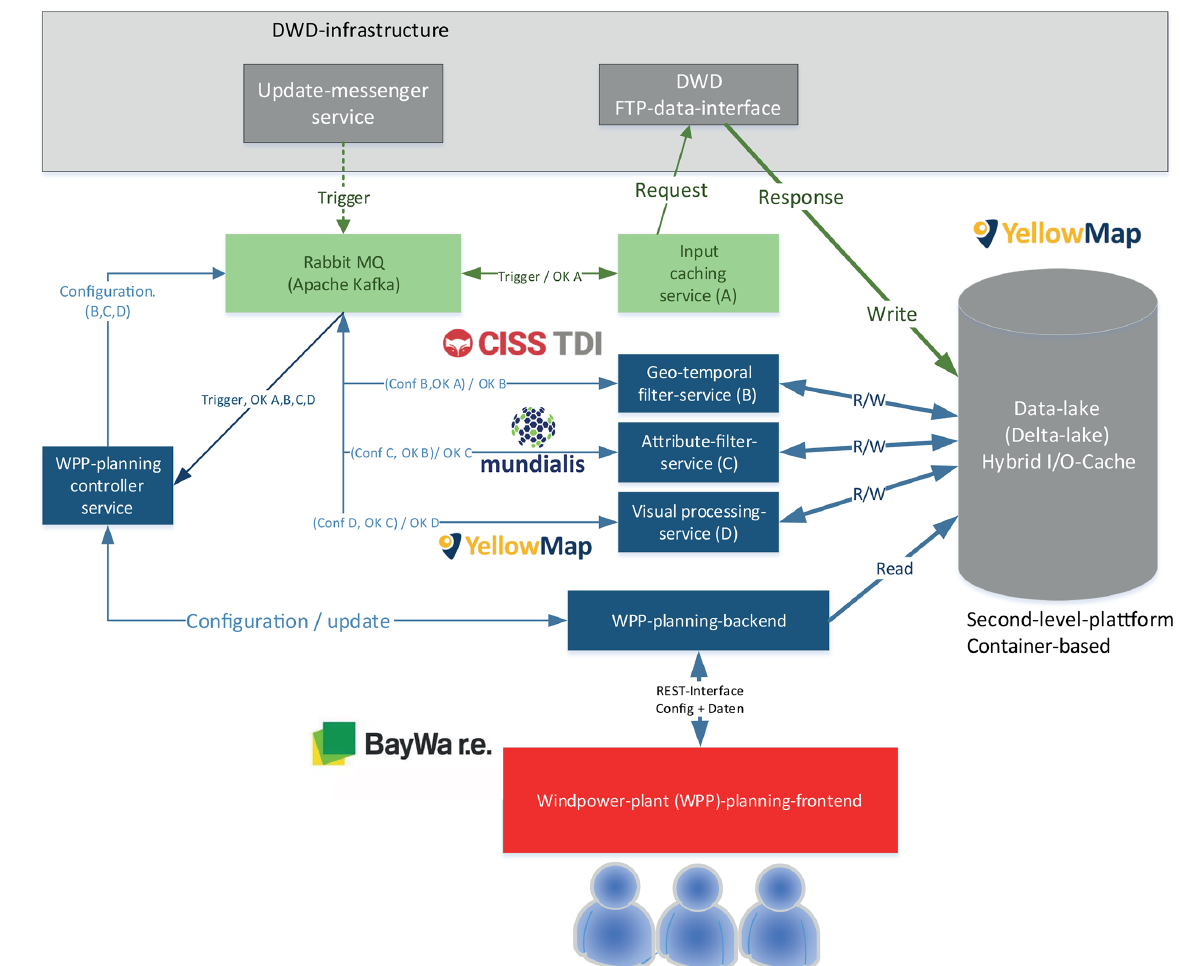
Figure 1. Schematic illustration of the